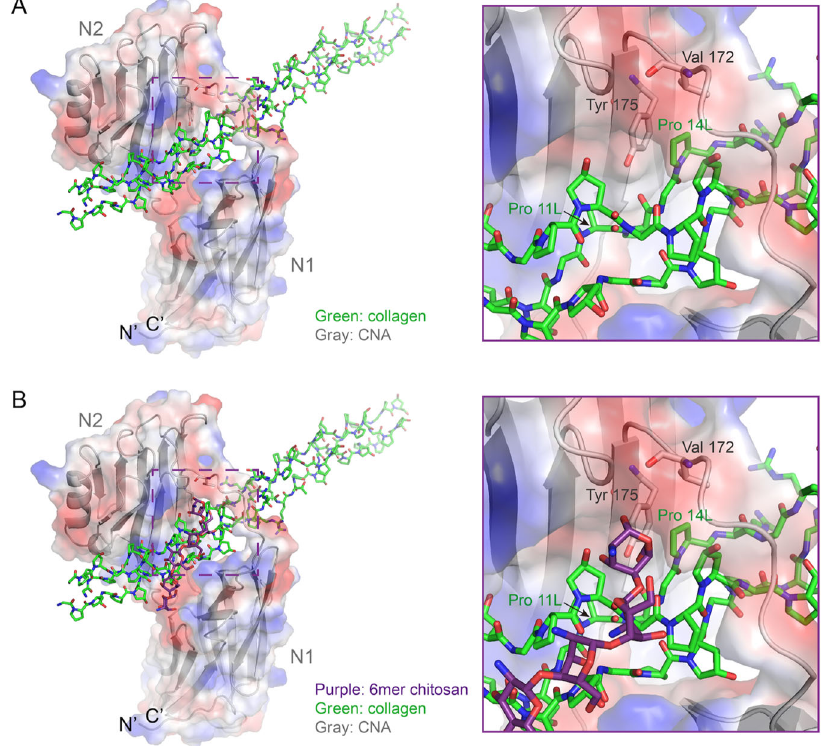
Fig. 6 The best docking model of 6mer chitosan ( B ) disrupts hydrophobic interactions between collagen peptide and CNA protein ( A ). Semitransparency electrostatic potential mapped onto the CNA protein surface. Red denotes a negative charge ( − 52.7 kT/e), and blue denotes a net positive charge ( + 52.7 kT/e)